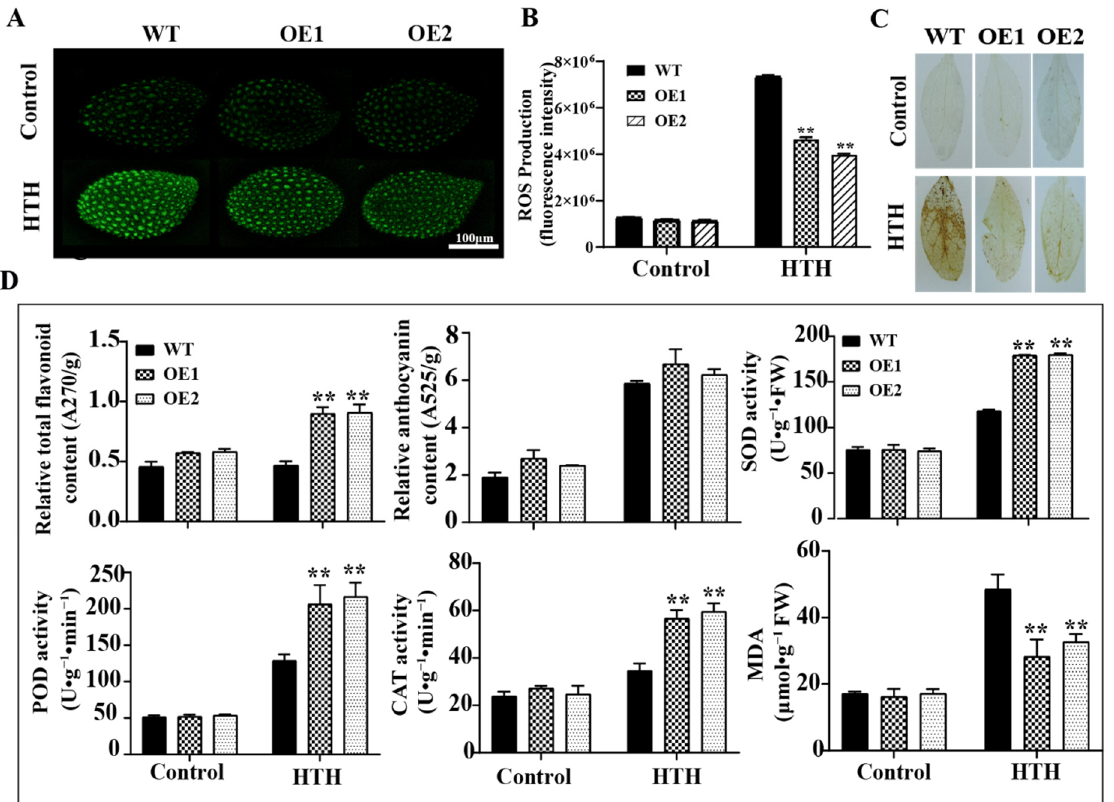
Figure 3. ROS content and physiological indexes of GmPAL1.1 overexpressing Arabidopsis (OE) lines and WT at physiological maturity stage after HTH stress. Control plants (WT and OE lines) were placed in a normal growth chamber (26 °C/24 °C, RH 70%, light for 16 h/dark for 8 h) for 3 d, and HTH-stressed plants (WT and OE lines) were put into artificial aging equipment (40 °C/24 °C, 98% RH/70% RH, light for 16 h/dark for 8 h) for 3 d. ( A , B ) ROS content in developing seeds. Developing seeds of Arabidopsis thaliana were incubated for 30 min in H 2 DCFDA buffer (10 mM H 2 DCFDA, 10 mM Hepes-NaOH, pH 5.7), photographed and observed using a laser confocal microscope, and the fluorescence intensity was measured by ImageJ. ( C ) DAB staining of leaves. ( D ) Flavonoids and anthocyanins content, antioxidant enzyme activities, and MDA content in leaves. Values are mean ± SD of three independent biological replicates, ** indicated significant differences at 1% probability levels between WT and transgenic Arabidopsis lines under HTH treatments.